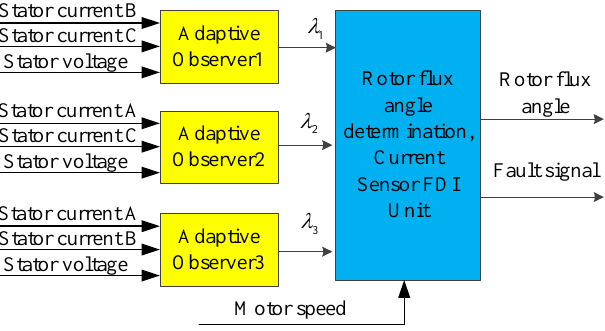
Figure 7. Current sensor fault diagnosis method in [43].